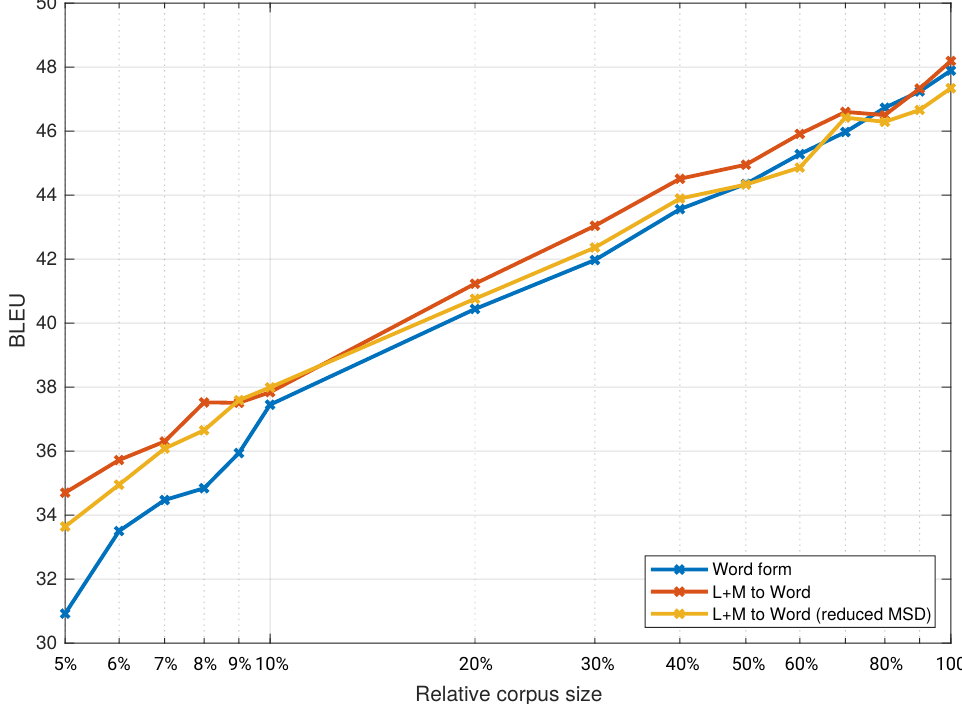
Figure 4. Translation results for the selected translation systems from Slovene to English using ParaCrawl with respect to relative training corpora